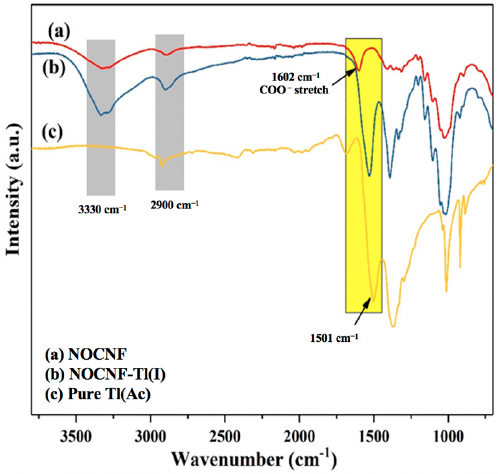
Figure 3. FTIR spectra of ( a ) NOCNF (0.32 wt%), ( b ) NOCNF-Tl (0.32 wt% NOCNF with 300 ppm Tl(I)), and ( c ) pure Tl(Ac).